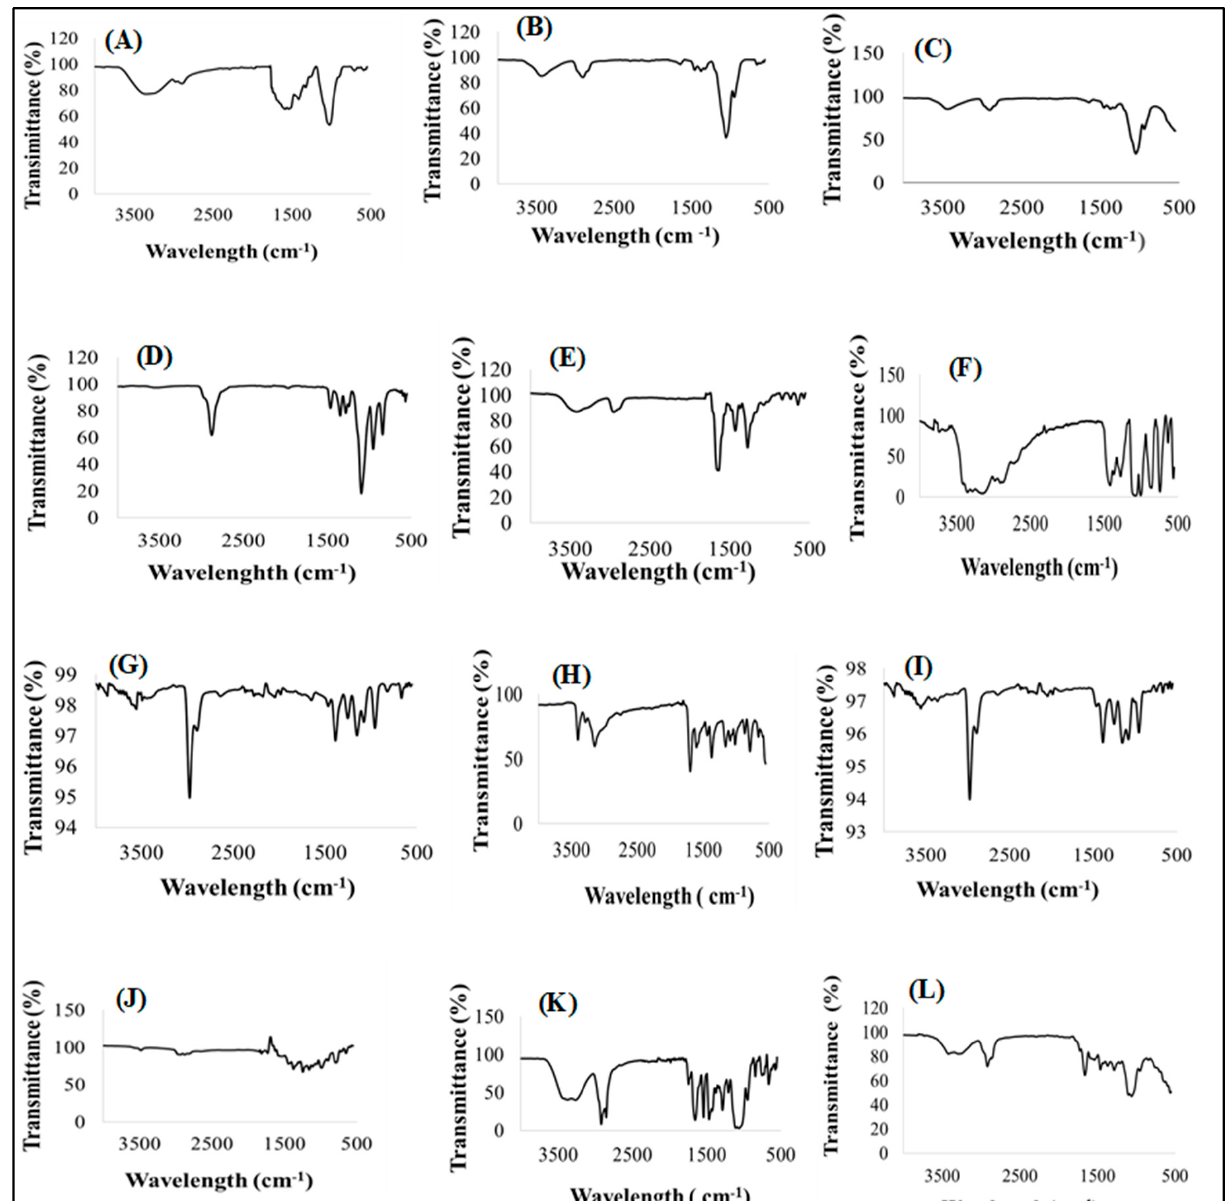
Figure 4. Fourier transform infrared spectroscopy of ( A ) Primellose ® , ( B ) methylcellulose ( C ) mag- nesium stearate, ( D ) Kolliphor ® , ( E ) polyvinylpyrrolidone, ( F ) xylitol ( G ) sodium chloride, ( H ) po- tassium chloride, ( I ) pyrazinamide, ( J ) rifampicin, ( K ) placebo and ( L ) the drug-loaded formulation. The pure drug pyrazinamide (Figure 4I) displayed specific peaks of N-H stretches at vibrations of 3414 cm − 1 and 3154 cm − 1 , C=O stretches at 1698 cm − 1 , C=N bends at 1596 cm − 1 , C=C bends at 1374 cm − 1 and C-N ring bends at 1166 cm − 1 [34,80,92]. The pure drug rifam- picin documented peaks at 3496 cm − 1 representing N-H stretch, O-H stretches at 2984 cm − 1 , C=O (keto group) stretches at 1694 cm − 1 , C=O (amine group) at 1794 cm − 1 and C=C ring stretches at 1456 cm − 1 in Figure 4J [93–95]. The placebo FTIR spectra (Figure 4K) showed O-H stretches at 3420 cm − 1 which could depict the presence of xylitol, Kolliphor ® , and methylcellulose, Primellose ® and magnesium stearate. There are strong CH 3 and CH 2 stretches at 2928 cm − 1 and 2930 cm − 1 , respectively indicating the presence of polyvinylpyr- rolidone, xylitol, Kolliphor ® , magnesium stearate, methylcellulose, sodium, and potas- sium chloride chemical backbone structure. Furthermore, peaks of C=O stretches at vibra- tions of 1658 cm − 1 depict the presence of polyvinylpyrrolidone, magnesium stearate and Primellose ® whereas C=C and C-C stretches at 1544 cm − 1 indicate the presence of xylitol. Peaks representing C-O stretches at vibrations of 1116 cm − 1 confirms the presence of Primellose ® , Kolliphor ® P188, magnesium stearate and methylcellulose. The presence of C-